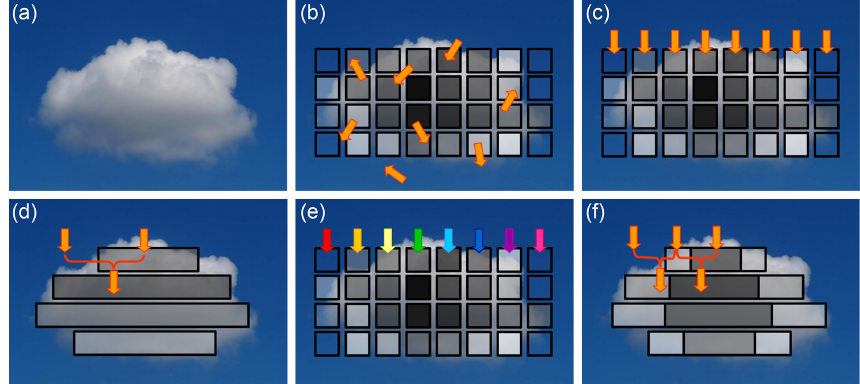
Figure 1. Divergent modeling of cloud–radiation interaction (arrows denote radiative fluxes; grey shading mirrors cloud optical thickness): (b) realistic 3-D radiation calculation on a high-resolution cloud; (c) the ICA approximation; (d) the conventional plane-parallel approach in coarse-resolution weather and climate models; (e) the McICA algorithm (rainbow-colored fluxes indicate calculations in various spectral bands); (f) the Tripleclouds